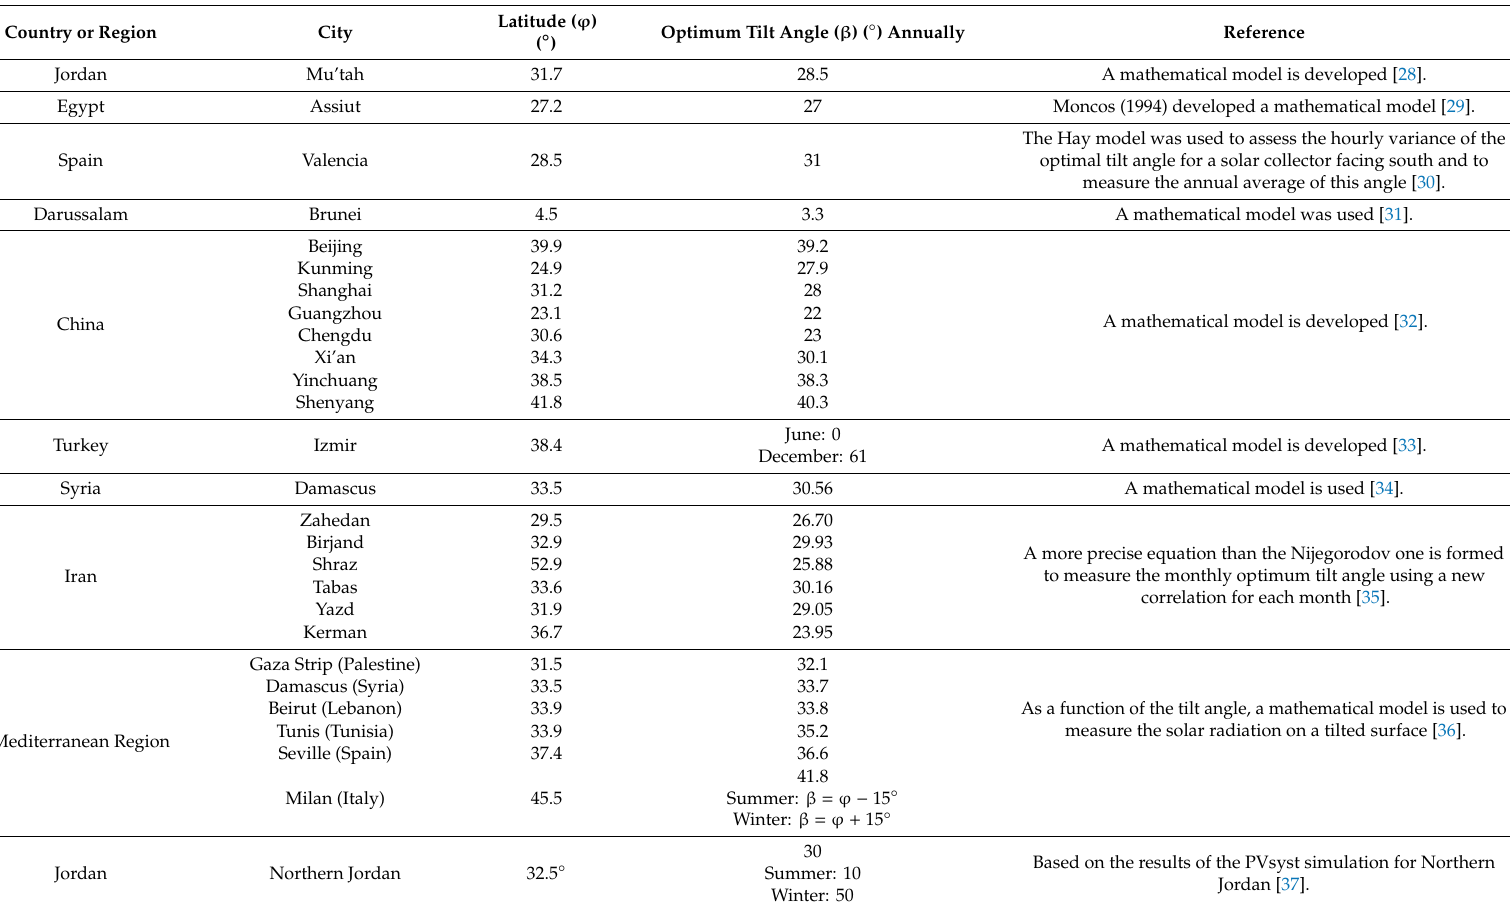
Table 1. Shows the optimum tilt angles using di ff erent methods for several countries worldwide from 1988 to 2020. Country or